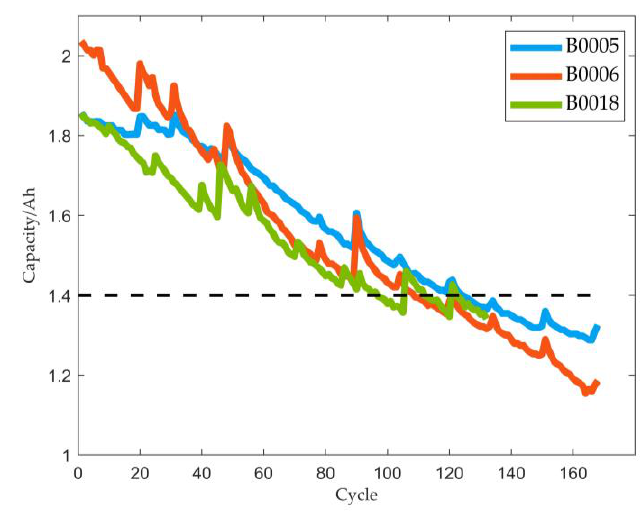
Figure 5. Capacity degradation curve of lithium-ion batteries.